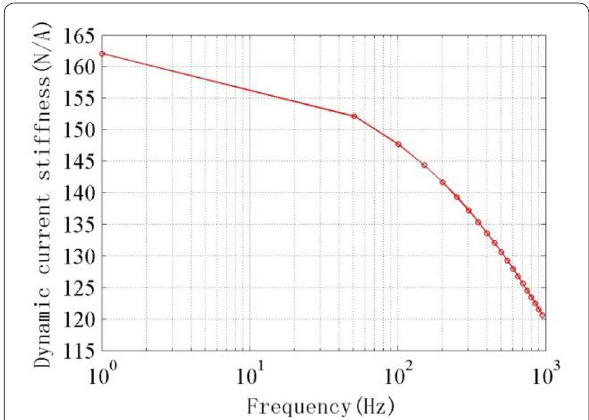
Figure 6 Dynamic current stiffness at different frequency Figure 7 Dynamic displacement stiffness at different